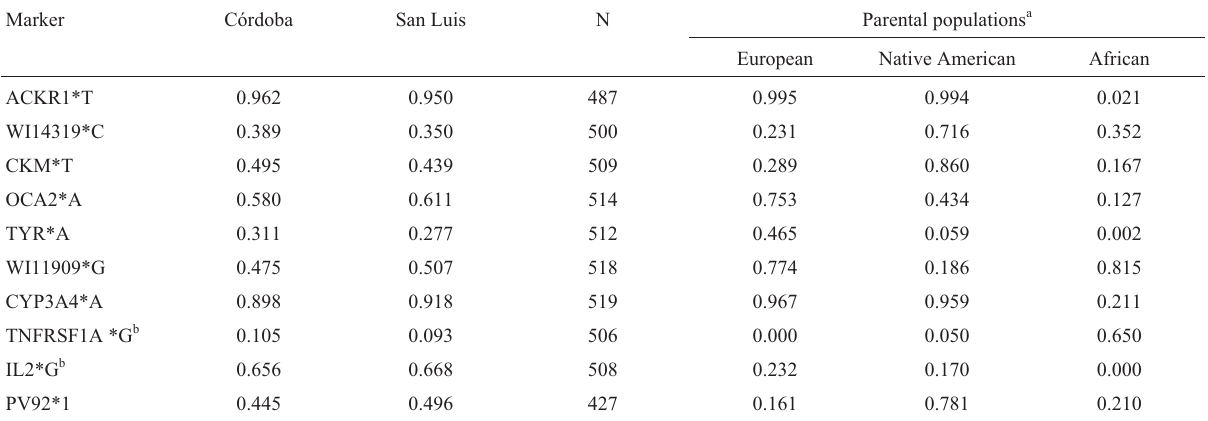
Table 2 - Summary of 10 AIM allele frequencies in the provinces of Córdoba and San Luis, and in the European, Native American and African parental stocks.